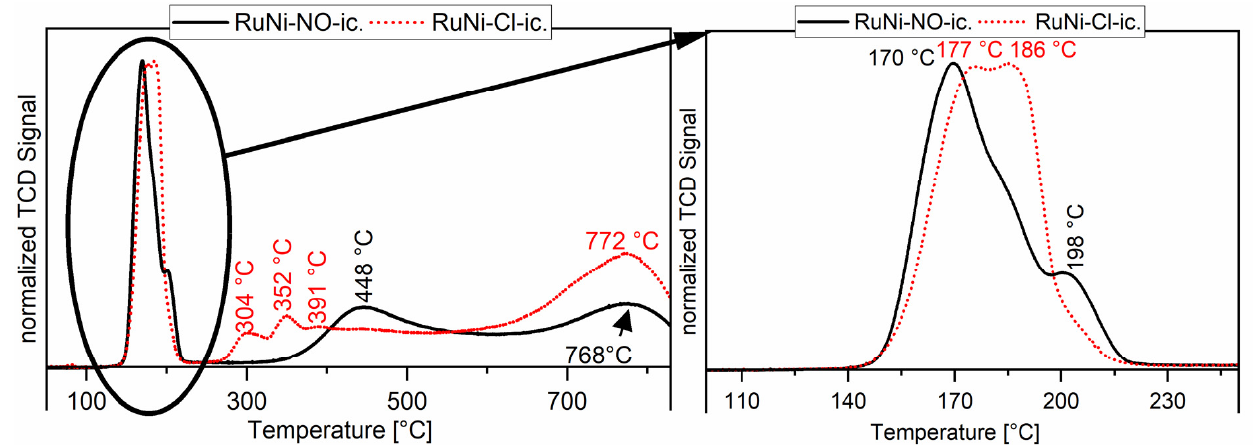
Figure 5. Temperature-programmed reduction of Ru/Ni on Al 2 O 3 catalysts. The black line shows the thermogram recorded for the RuNi-NO-ic. catalyst and the dotted red line shows the thermogram recorded for the RuNi-Cl-ic. catalyst.